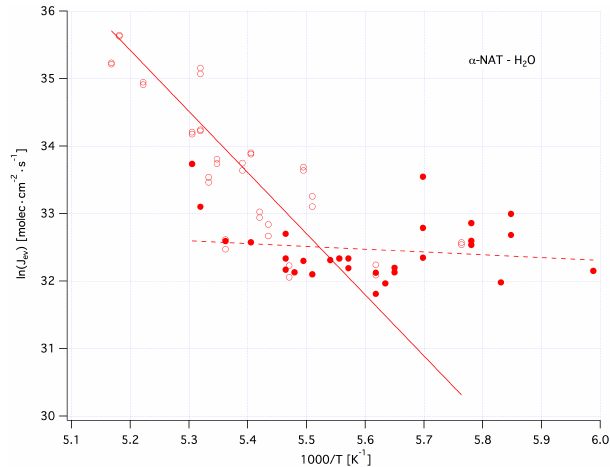
Figure 10. Arrhenius plot of J ev (H 2 O) for α -NAT. Full and empty red circles represent results of PV and TO experiments, respectively. Data are taken from Fig. 2b, and the equations for the linear fits may be found in the